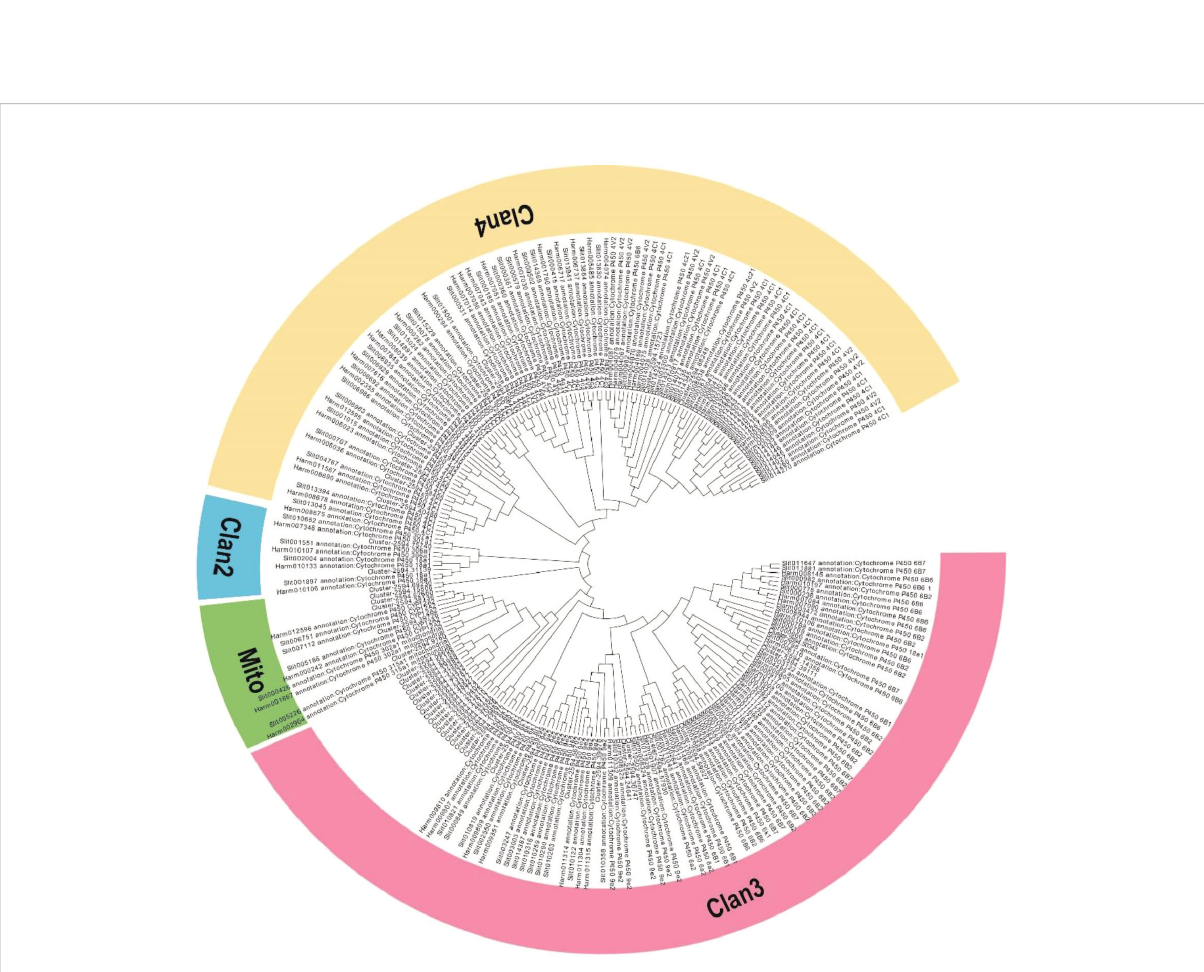
FIGURE 4 Phylogenetic analysis of the CYP450 genes from M. separata , H. armigera , and S. litura . The tree was constructed from multiple sequence alignments using MEGA-X software.